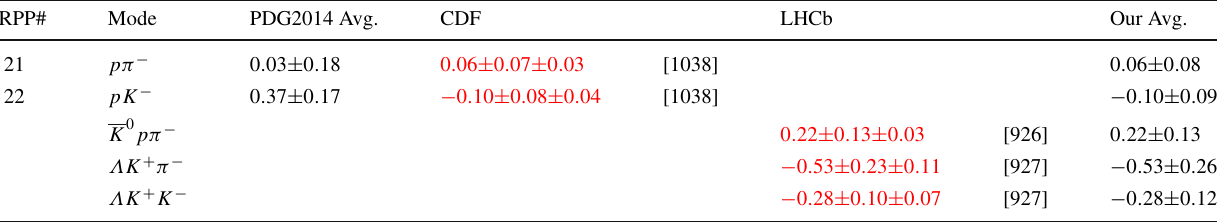
Table 247 CP asymmetries of charmless hadronic Λ 0 (preliminary) results since